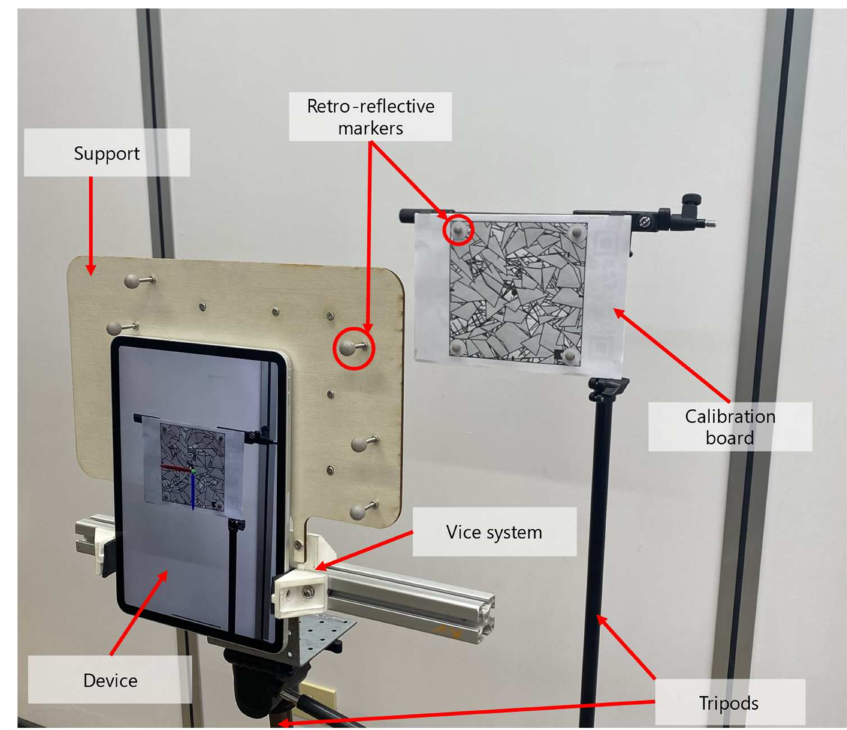
Figure 5. Calibration